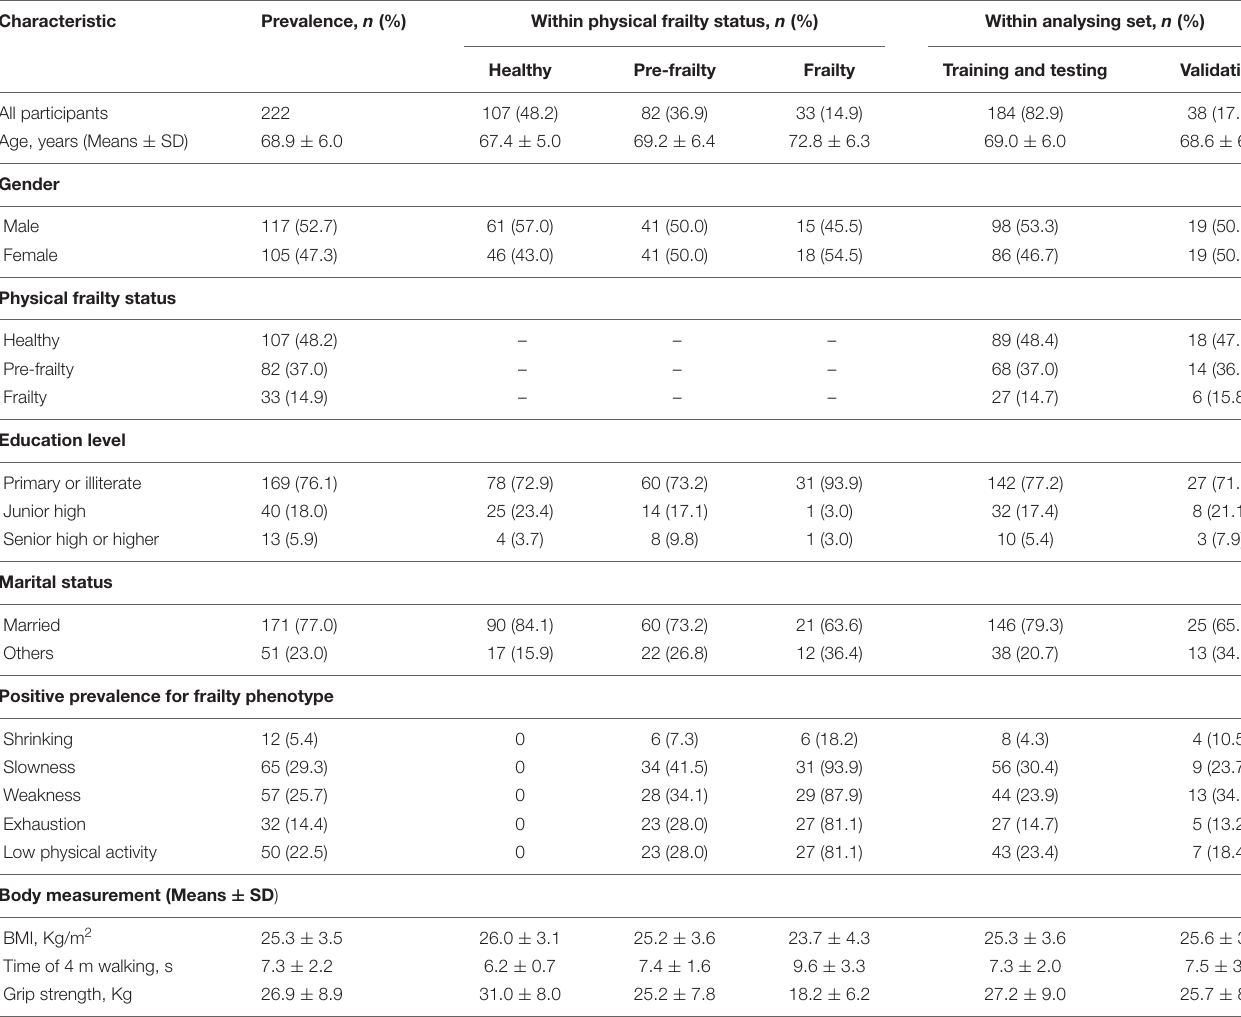
TABLE 1 | Characterisation and physical status of participants among 222 older adults aged > 60 in the three-class identification experiment. Characteristic Prevalence, n (%) Within physical frailty status, n